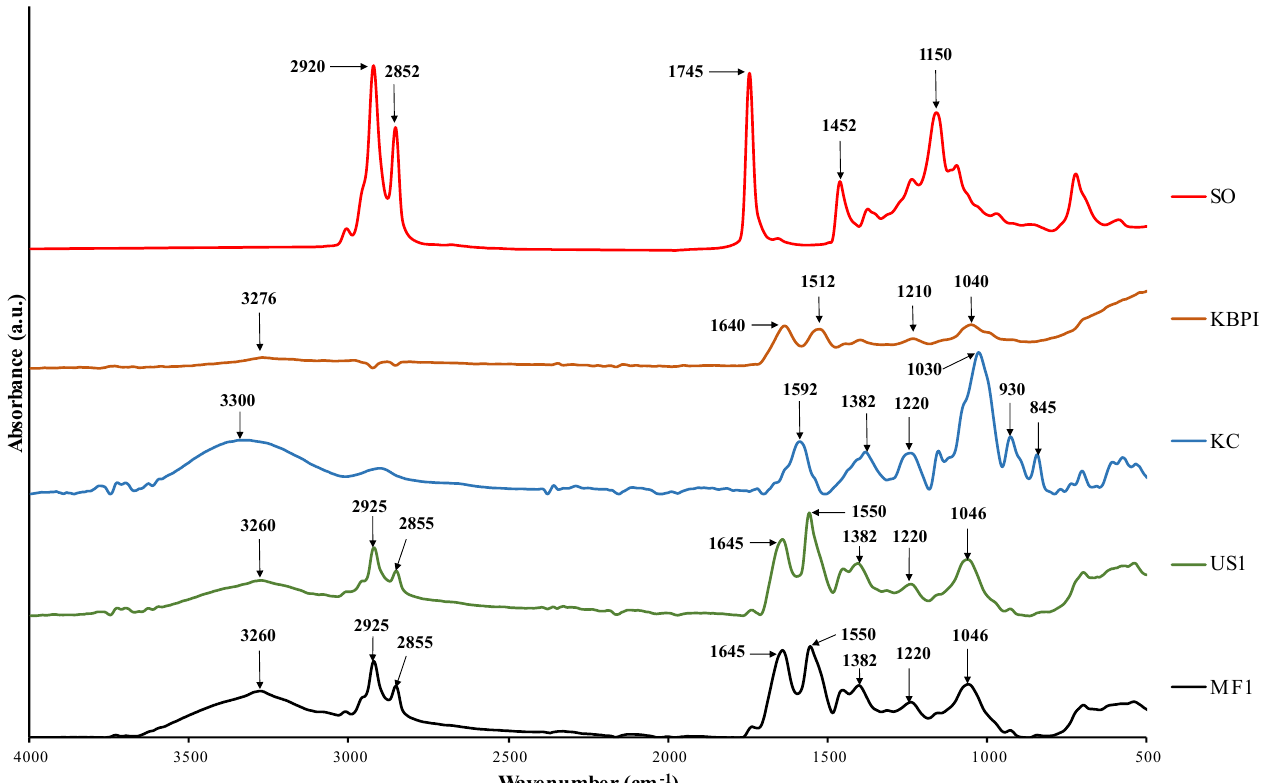
Figure 2. FTIR spectra of SO, KBPI, KC, US1 and MF1. SO, shrimp oil, KBPI, kidney bean protein isolate; KC, κ -carrageenan; US1, ultrasonicated KBPI-KC-SO microcapsules containing 0.1% SO; MF1, microfluidized KBPI-KC-SO microcapsules containing 0.1% SO.